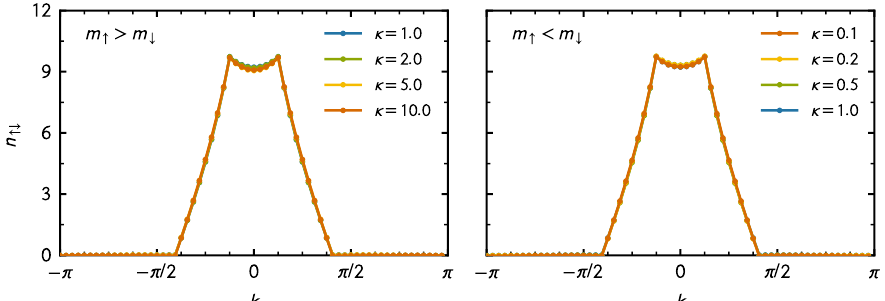
Figure 5: Pair-momentum distribution n ↑↓ for mass-imbalanced systems with ( N ) = ( 17,9 ) particles on a lattice of N = 64 sites and ˜ γ = − 2.0. Left panel : ↑ , N ↓ x Heavy-majority systems with mass ratios κ = 1.0,2.0,5.0,10.0. Right panel : Heavy- minority systems with mass ratios κ = 0.1,0.2,0.5,1.0. The statistical error bars are smaller than the symbol